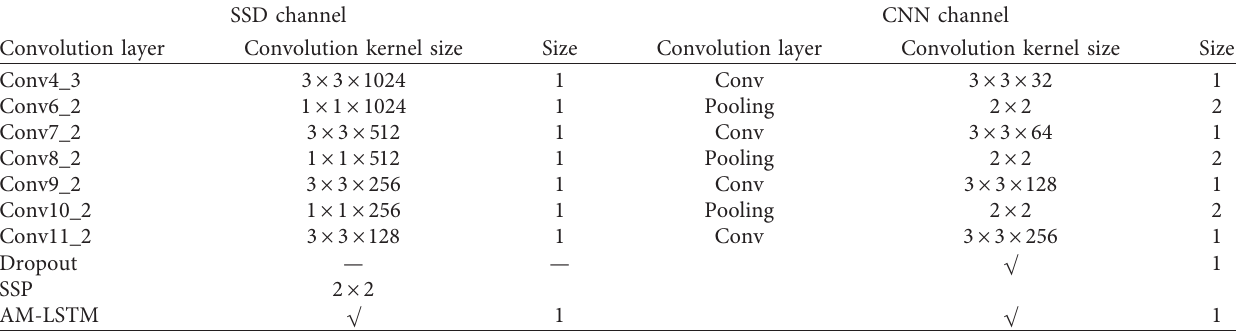
Figure 4: Hybrid dual-channel CNN +AM-LSTM network structure. Table 1: Parameters of dual-stream convolution